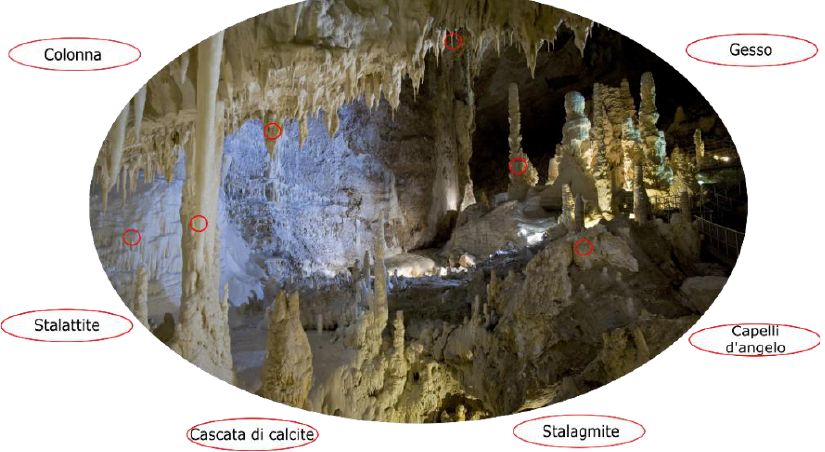
Figure 5. The third activity, where the elements visible in the cave must be connected with their names.